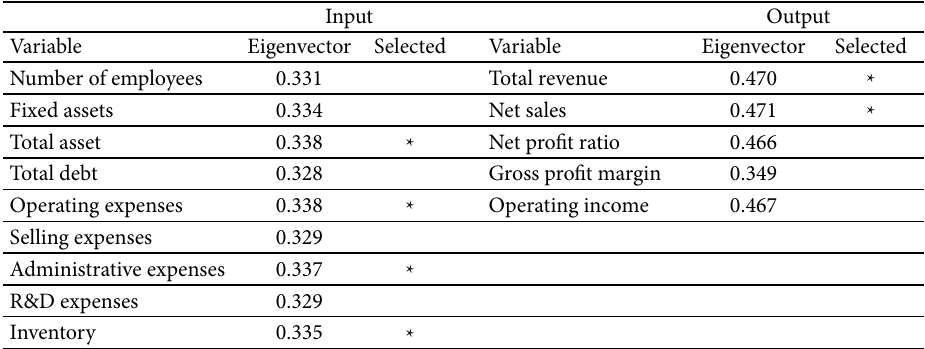
Table 2. The selection of input and output variables based on the globalized